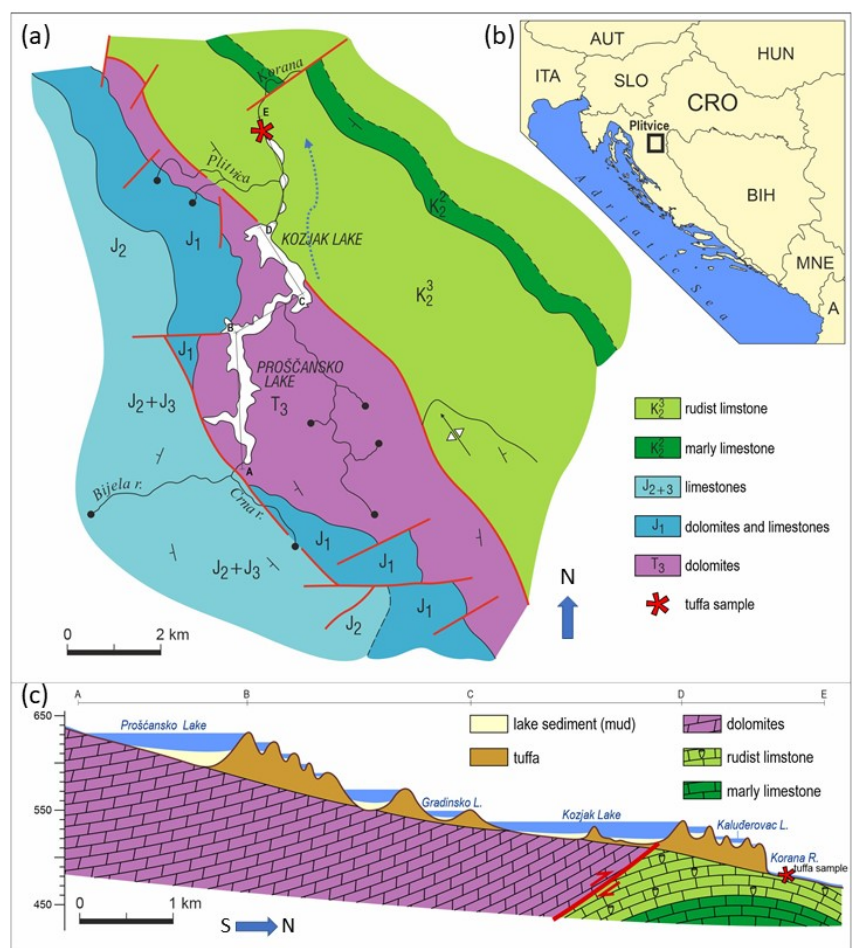
Figure 1. ( a ) Geological map of the Plitvice Lakes area (modified after [50]) with the location of the analyzed tufa (marked with red star) and dashed arrow indicating the flow direction, ( b ) setting of the Plitvice Lakes in Croatia. Croatia is bordered by Italy (ITA), Slovenia (SLO), Hungary (HUN) and Bosnia and Herzegovina (BiH), ( c ) geological pro fi le through Upper and Lower Lakes, with clear distinctions between lithology of the basement rocks (modi fi ed after [51], image created by Robert Koš č al).